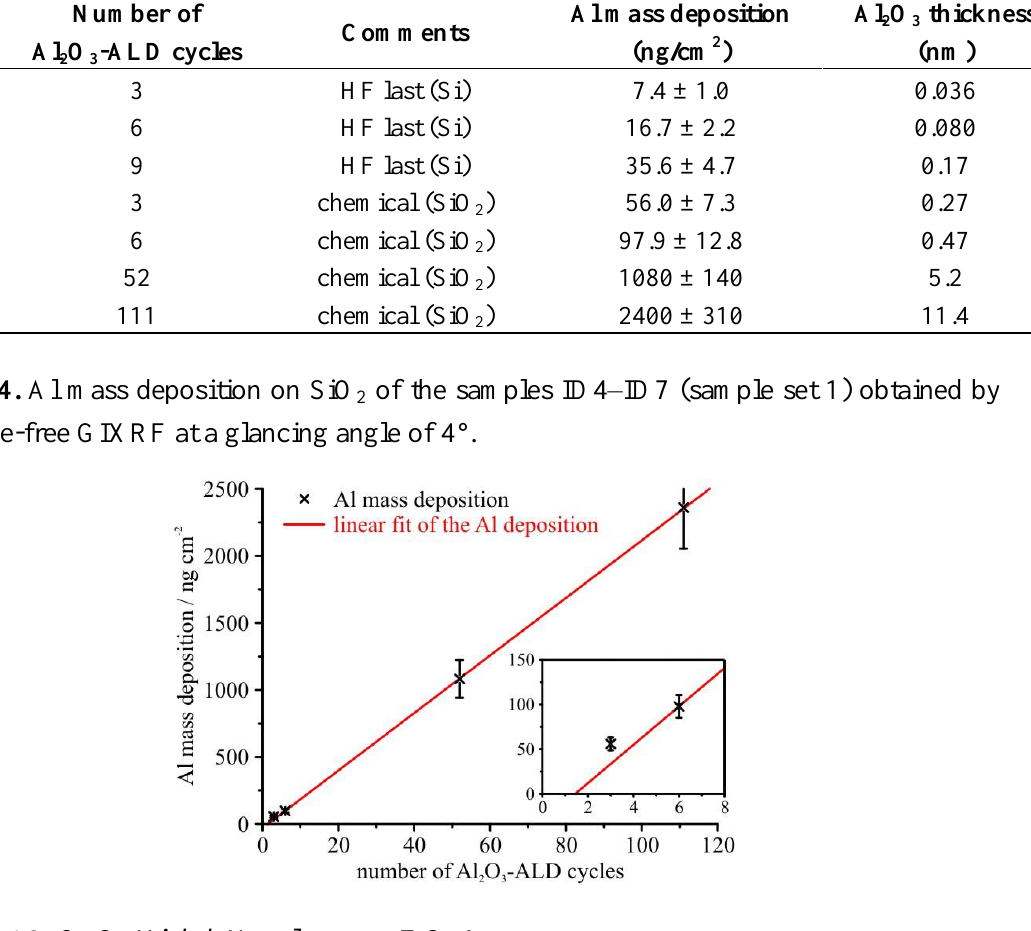
Table 2. Mass depositions and high-k layer thicknesses of sample set 1 determined by Grazing Incidence X-ray Fluorescence (GIXRF) at a glancing angle of 4°. For better clarity, the respective mass deposition was transferred into a layer thickness using the bulk density and a 2 to 3 stoichiometry.